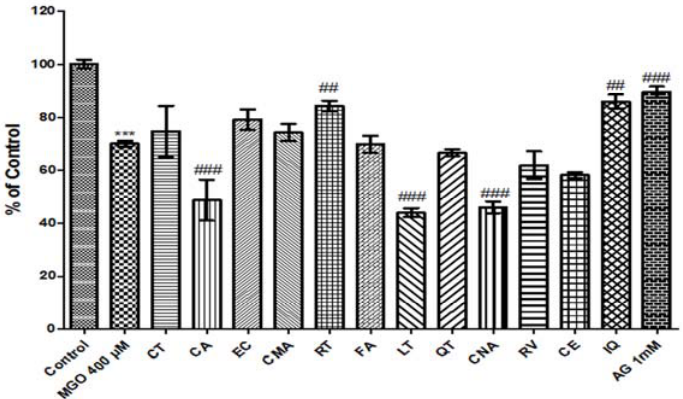
Figure 5. Protective effect of phenolics on methylglyoxal (MGO) ‐ induced cell death. Human umbilical vein endothelial cells were pretreated with 100 μ M of phenolic compound for 1 h, followed by MGO treatment (400 μ M). Bar values are presented as the mean ± SD of three independent experiments. (*** p < 0.001 vs. control; ## p < 0.01 and ### p < 0.001 vs. MGO treatment only).